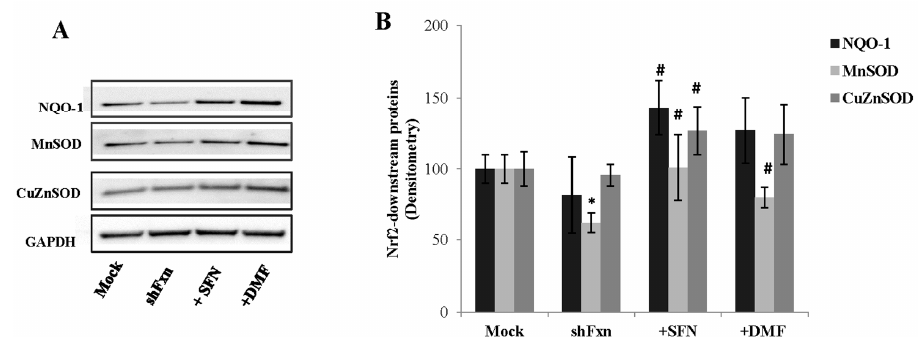
Figure 2. Nrf2 inducers activate the phase II response in shFxn. ( A ) Representative Western blot of downstream Nrf2 target proteins. An amount of 40 µg Mock, shFxn 5 µM (24 h) SFN and 30 µM (24 h) DMF treatments were applied onto 4–12% Bis–Tris SDS-polyacrylamide gel electrophoresis and probed with anti-NQO-1 (1:1000), MnSOD (1:5000) and Cu/ZnSOD (1:5000) antibodies; ( B )